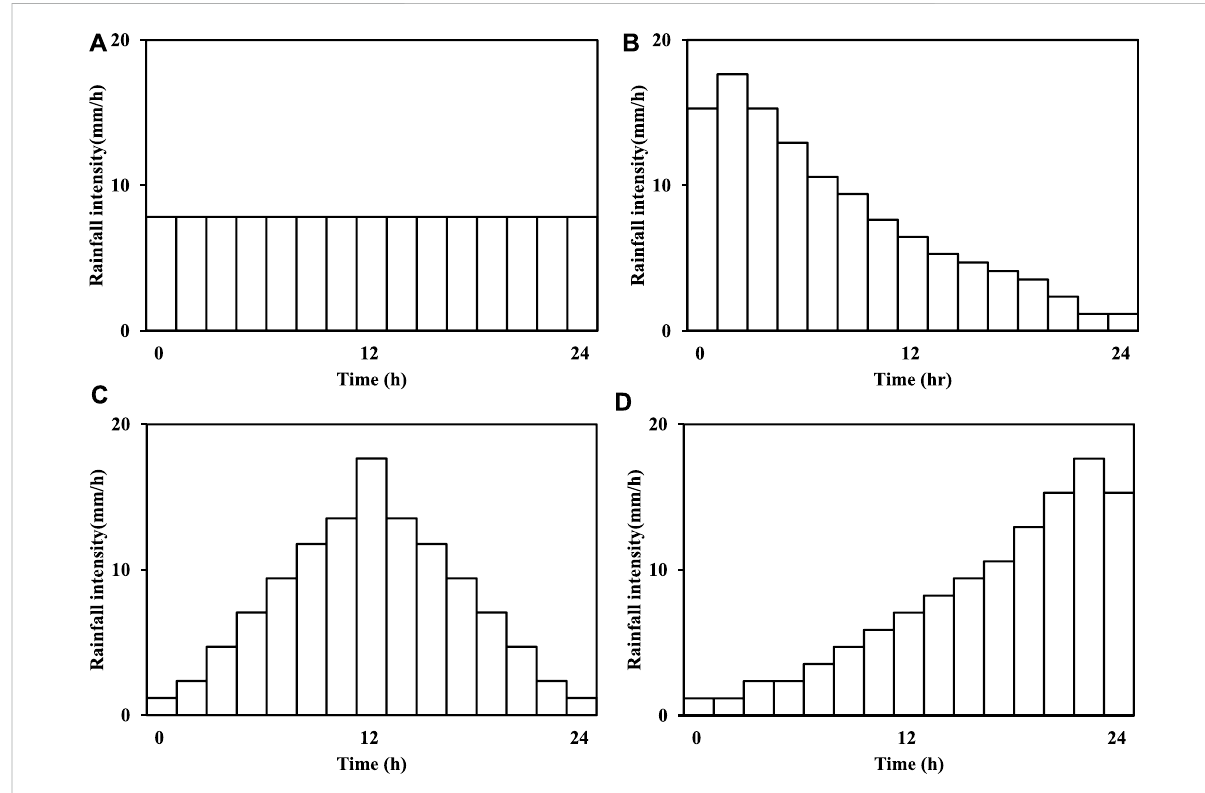
FIGURE 9 Four rainfall patterns with the same accumulated rainfall, 200 mm: (A) uniform rainfall pattern, (B) delayed rainfall pattern, (C) normal rainfall pattern, (D) advanced rainfall pattern.